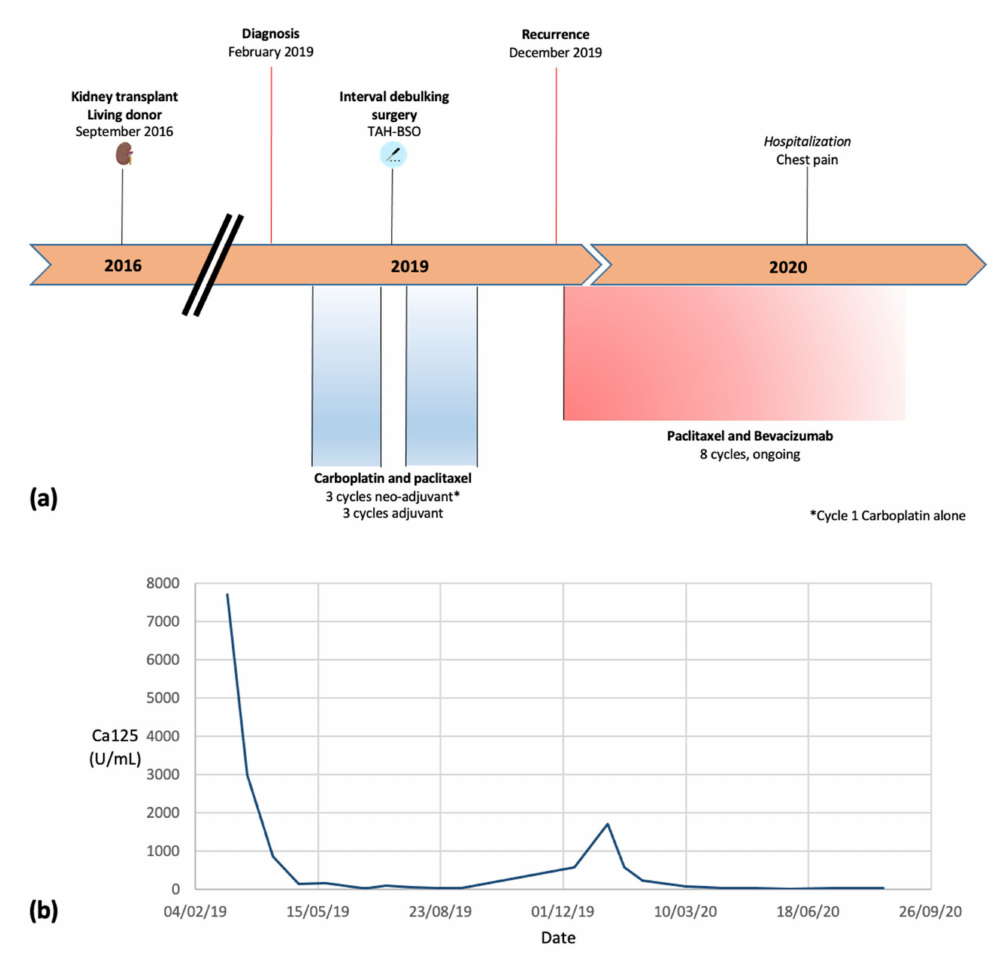
Figure 2. ( a ) Summary oncology treatment timeline. ( b ) Ca125 trend from diagnosis to